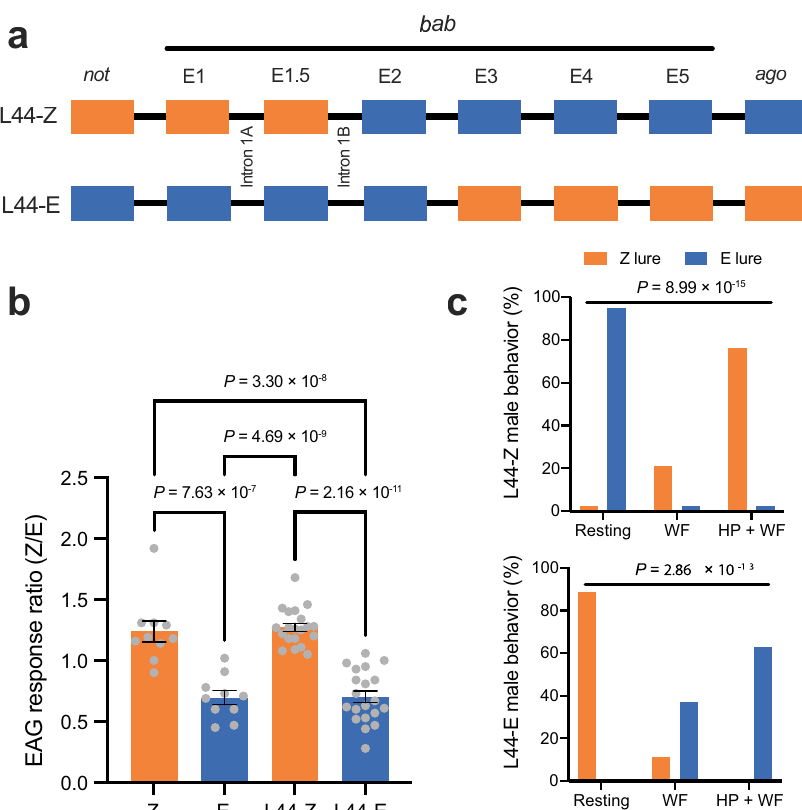
Fig. 2 Electrophysiological and behavioral analysis of bab -recombinant lines. a Crossover points relative to exons of bab within lines L44-Z and L44-E. Boxes represent exons 1 – 5, orange gene regions originated from the Z-strain and blue from the E-strain. Locations of introns 1A and 1B are noted. Flanking genes ago and not are each represented by a single box. b Electroantennogram (EAG) response ratio of pure strain and bab -recombinant males. Data are presented as mean ± SEM of EAG response (in mV) to Z11-14:OAc divided by response to E11-14:OAc. Sample sizes of measured animals are Z-strain n = 10, E-strain n = 10, L44-Z n = 20, L44-E n = 20. Z-strain and Z-like responses are shown in orange, E-strain and E-like responses are shown in blue. P values report results of two-sided Tukey ’ s HSD post-hoc tests after an ANOVA ( F = 38.67, df = 3, P = 1.13 × 10 − 13 ). c Wind tunnel responses of L44-E and L44-Z males to the Z-strain pheromone lure (97% Z-isomer, 3% E-isomer) are shown in orange and to the E-strain lure (1% Z-isomer, 99% E-isomer) in blue. P values report results of chi-square tests for L44-Z ( χ 2 (2, n = 38 animals) = 64.89) and L44-E ( χ 2 (2, n = 35 animals) = 57.76). Resting, no response to pheromone; WF wing-fanning response to pheromone, HP + WF wing-fanning and hair-pencil extrusion response to pheromone. Source data are provided as a Source Data fi